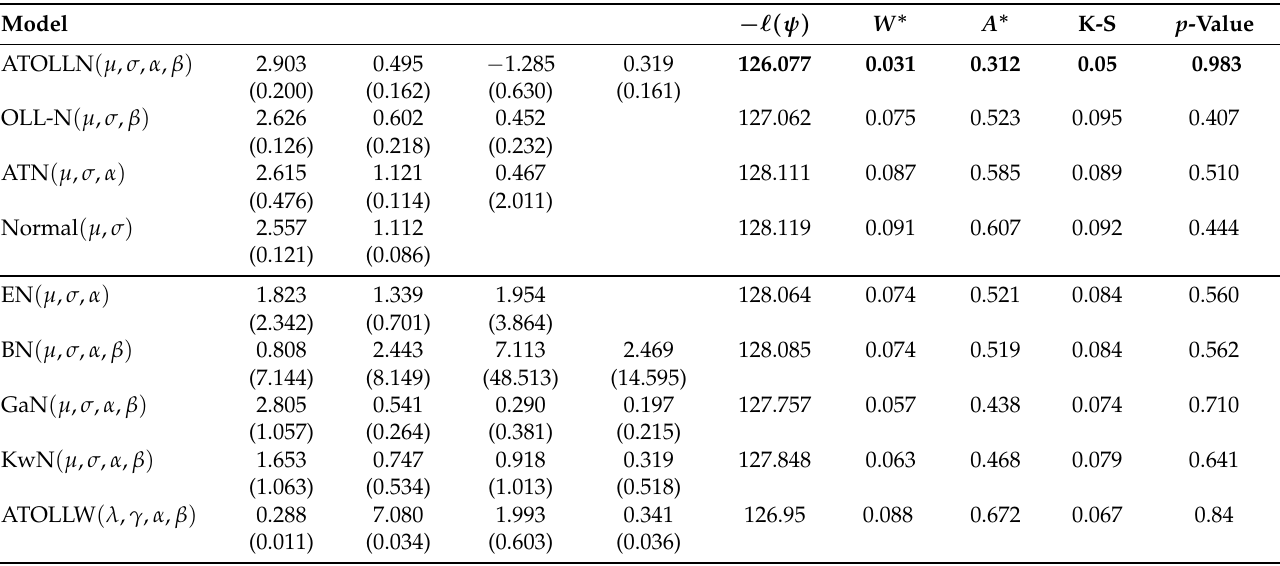
Table 2. A summary of model fitting to the failure times